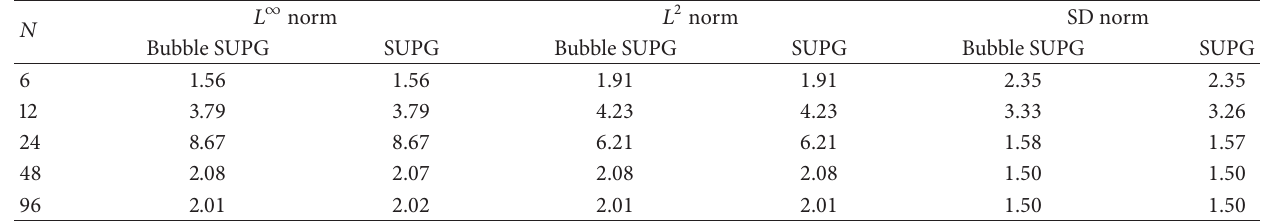
Table 11: 𝜀 = 10 −2 , Problem 3 (comparison of error).